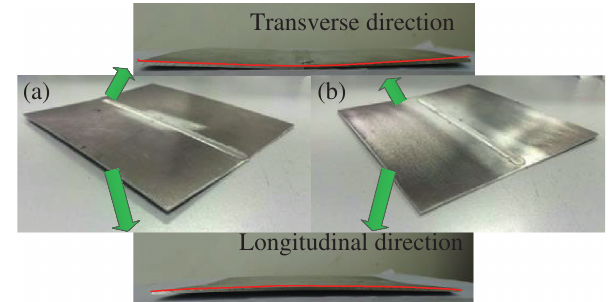
Figure 11: Distortion of workpiece in experimental results: (a) conventional cooling and (b) TIC.